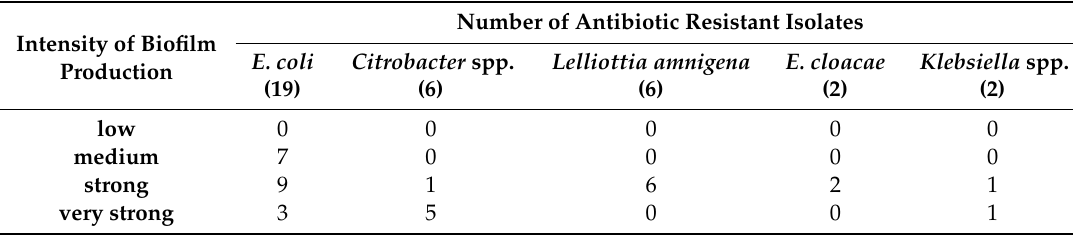
Table 6. Ability of antibiotic resistant coliform bacteria isolated from HEs to form